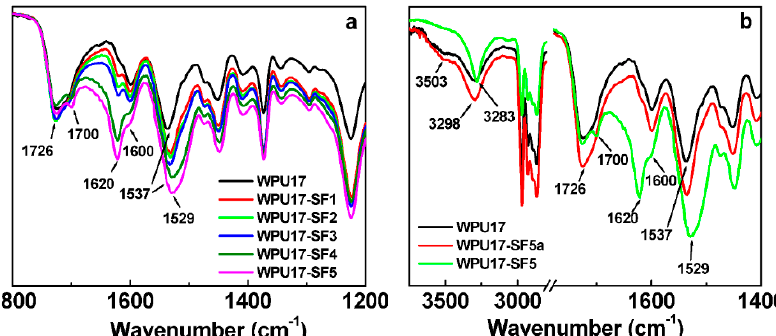
Figure 4. FTIR spectra of the WPU17, WPU17-SF and WPU17-SF5a films: ( a ) FTIR spectra of the WPU17 and WPU17-SF films in the wavenumber range of 1800–1200 cm − 1 ; and ( b ) FTIR spectra of the WPU17, WPU17-SF5a, and WPU17-SF5 films in the wavenumber range of 3750–1400 cm − 1 .